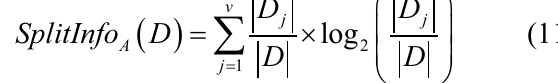
Information gain applies a kind of normalization to information gain using split information value defined analogously with